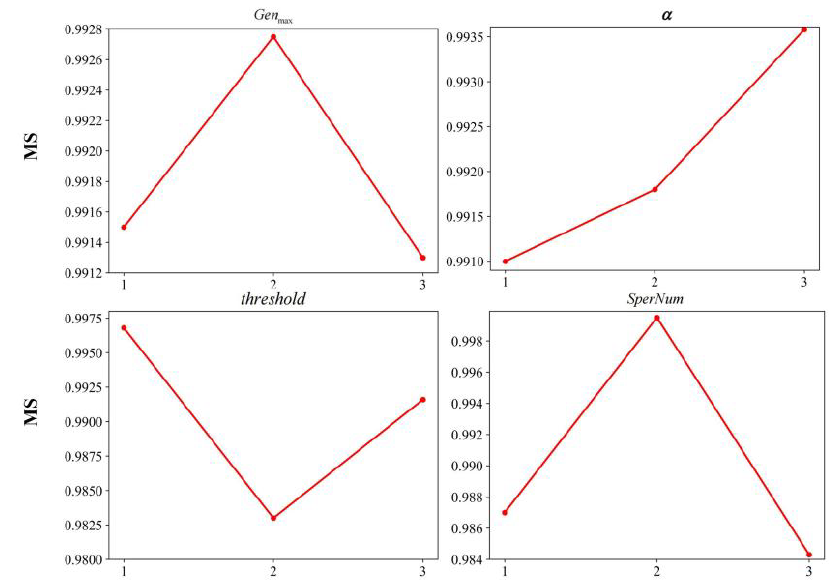
Figure 13. Main effect plot of major parameters.